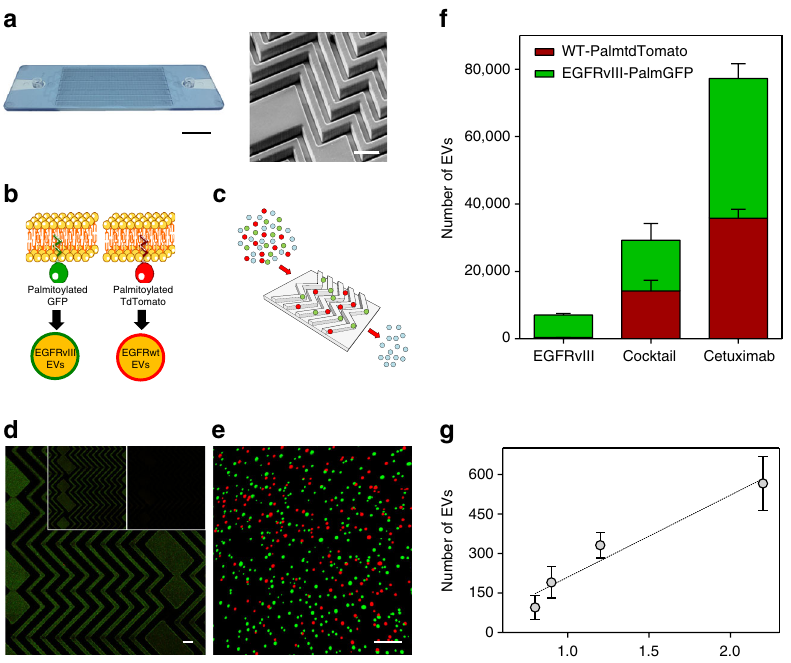
Fig. 1 EV HB-Chip design and reporter constructs. a Image of the operating COC EV HB-Chip. Pressure-driven fl ow-pumped serum or plasma through an inlet at 1 mL h − 1 . Waste serum or plasma is collected in a single outlet (scale bar 1 cm). On the right, a SEM micrograph of the 3D herringbone features of the micro fl uidic device (scale bar 100 μ m). b Gli36wt or Gli36-EGFRvIII glioma cells were stably infected with lentivectors encoding palmitoylated-tdTomato (PalmtdTomato) or -GFP (PalmGFP), respectively, to produce fl uorescently labeled EVs. c Serum or plasma from healthy donors with spiked-in fl uorescent EVs (in red and green) was run through the micro fl uidic device coated with tumor-speci fi c antibodies to capture tumor EVs. d A collage of one hundred confocal microscopy images of fl uorescent EVs captured on the surface of the device. Different antibodies were used: large image (Cetuximab, scale bar 50 μ m); right insert (antibody cocktail); left insert (anti-EGFRvIII). e Representative image of digitally rendered signals of captured EVs shown as green (EGFRvIIIPalmGFP EV) or red spheres (WT-PalmtdTomato EV; scale bar 1 μ m). f Quanti fi cation of captured wild-type PalmtdTomato and EGFRvIII PalmGFP EVs on the micro fl uidic device when different antibodies were used. A concentration of 20 μ g mL − 1 were used for EGFRvIII and Cetuximab, and 10 μ g mL − 1 for each antibody present in the cocktail ( n = 3 technical replicates; ± standard error of the mean, s.e.m.). g After imaging captured EVs were lysed. Total RNA was isolated and correlated to confocal microscopy data ( n = 3 technical replicates; ±